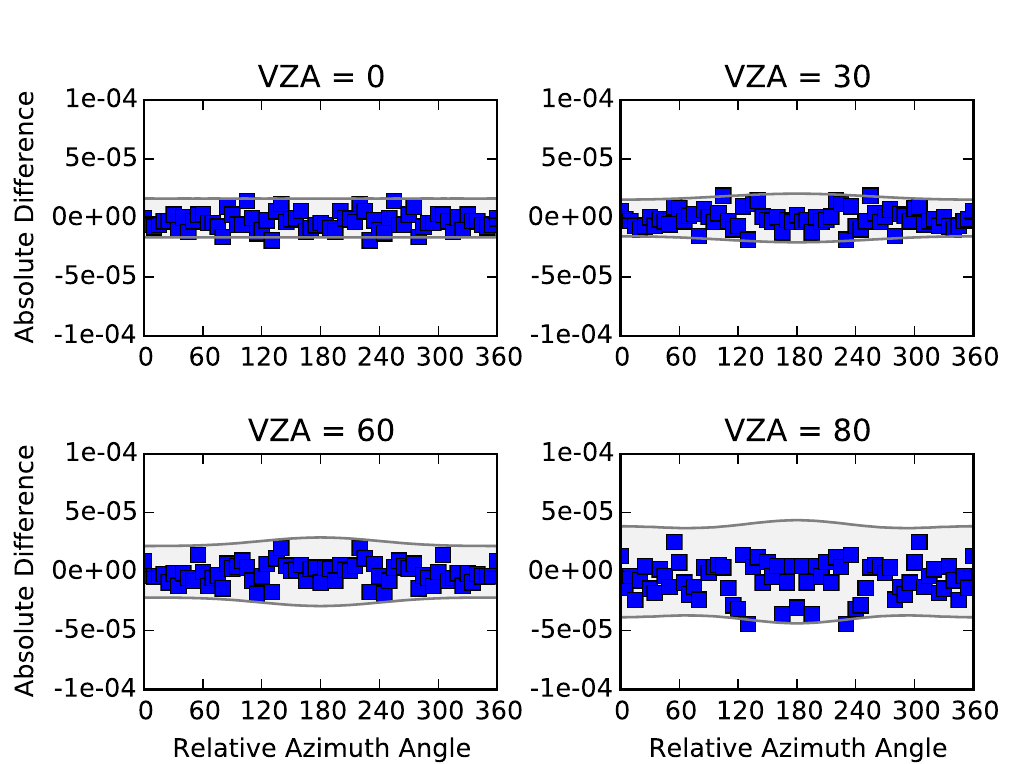
Figure A1. Difference in total intensity between VLIDORT and MYSITC for the aerosol profile scenario (B3). The gray lines represent the 2-sigma uncertainty reported by MYSTIC, a Monte Carlo